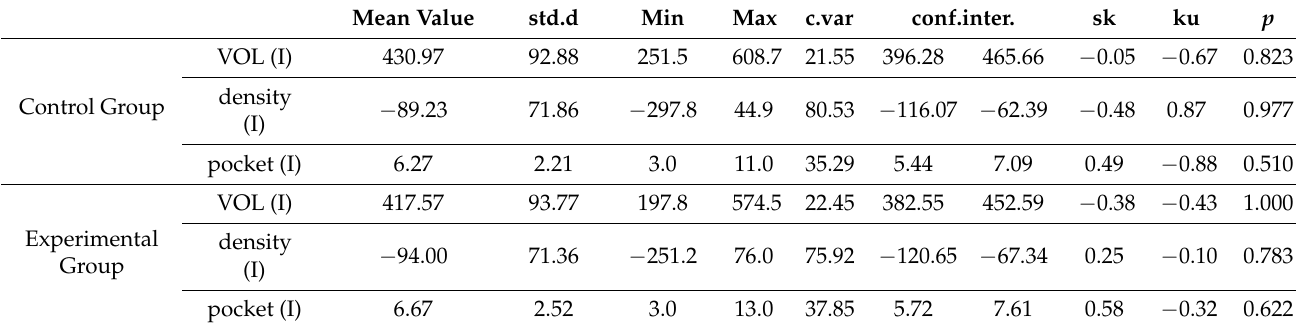
Table 2. Results of I measurement in the control and experimental groups. Mean Value std.d Min Max c.var conf.inter. sk ku p